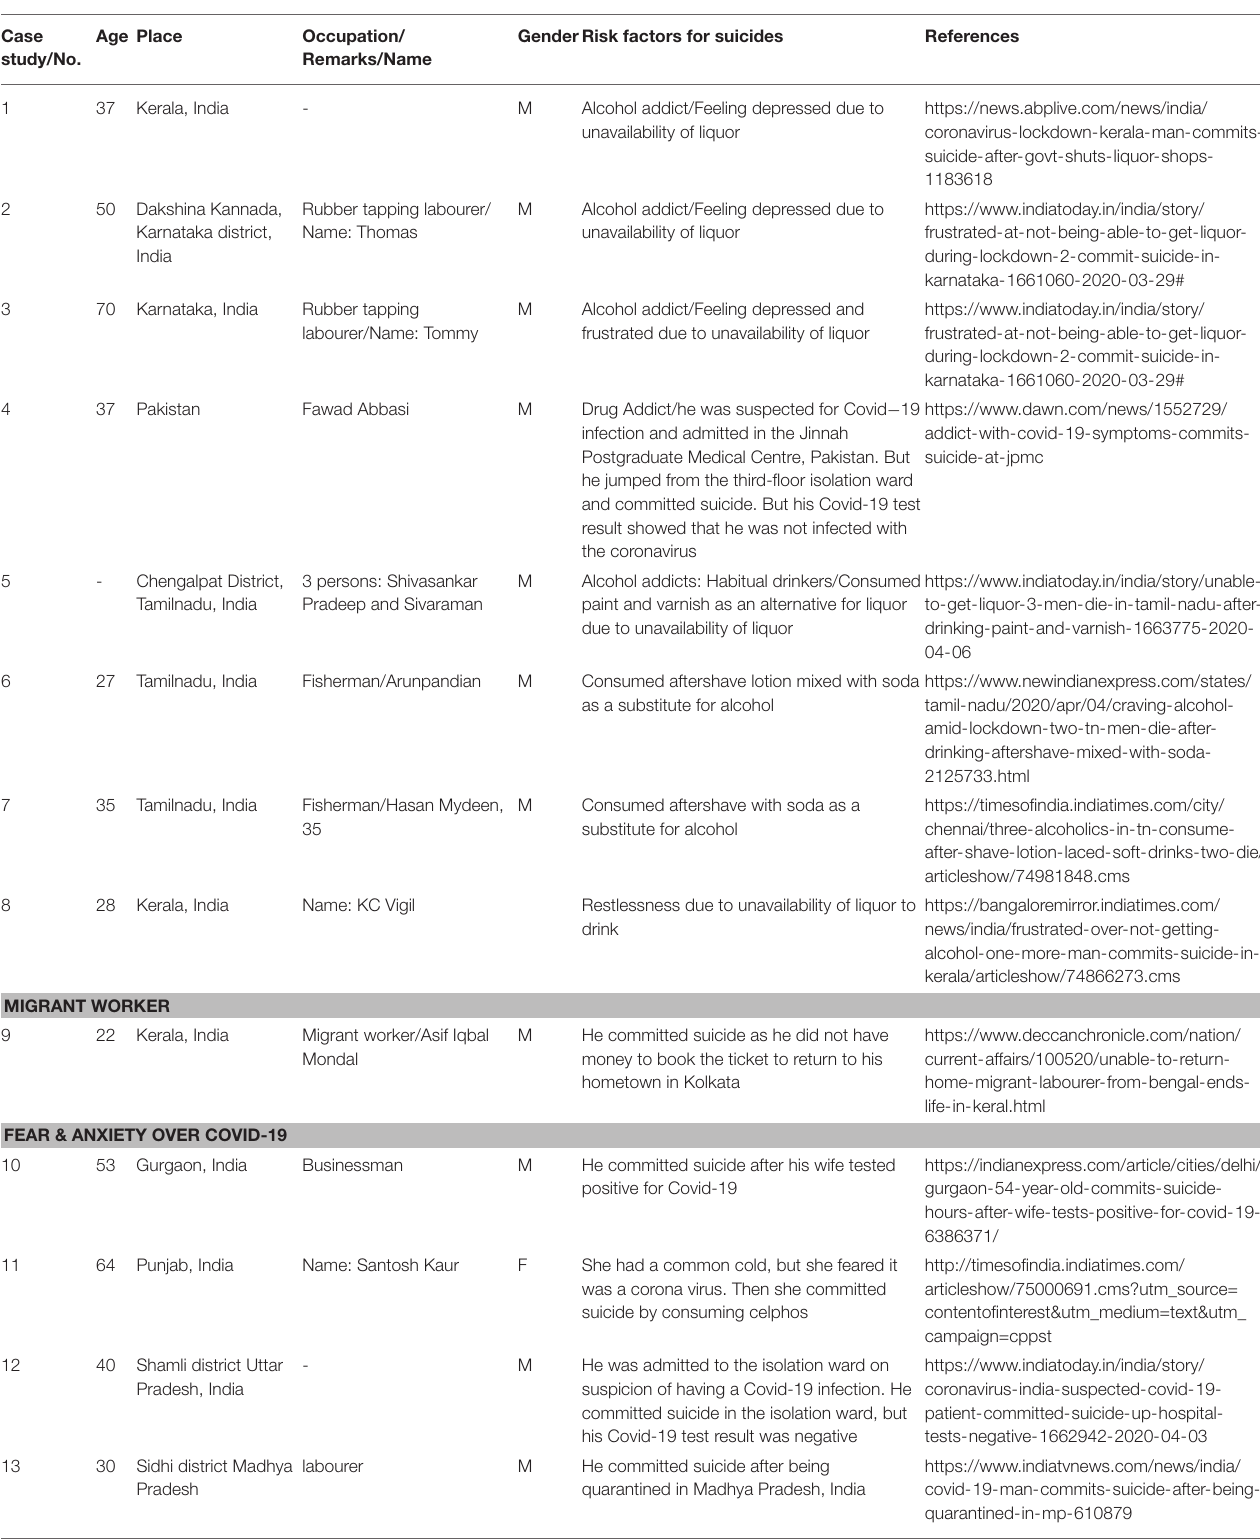
TABLE 1 | Impact of Covid 19 and suicides (up to May 2020). Case Age study/No.